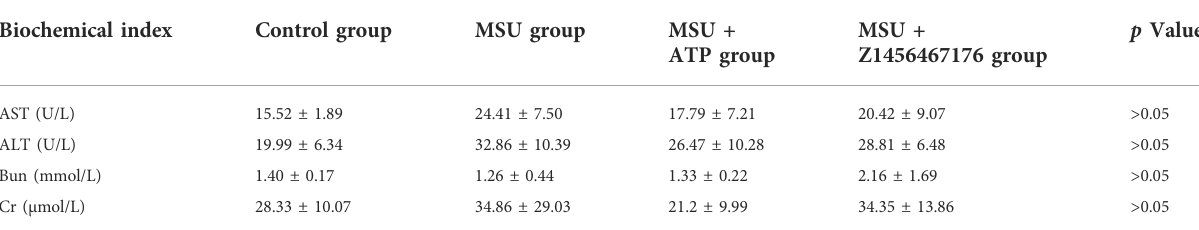
TABLE 1 Biochemical parameters of rats in gout